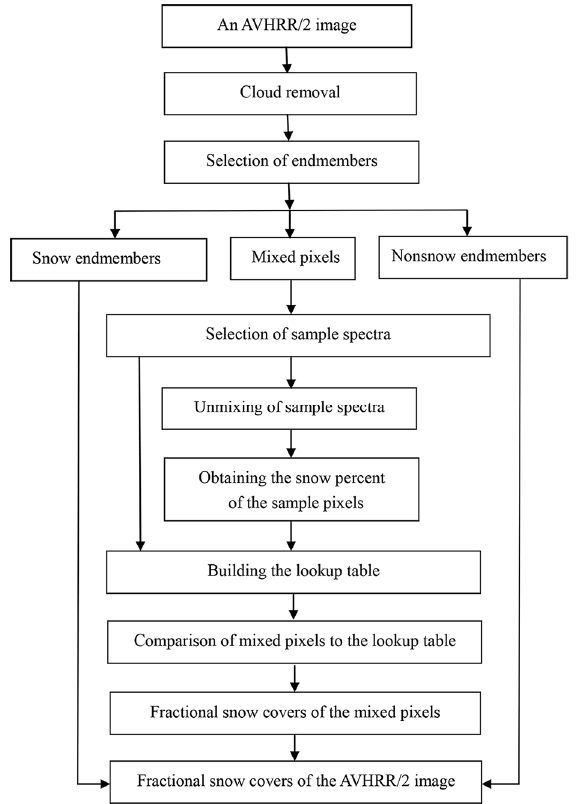
Figure 8. Steps of subpixel snow mapping using daily AVHRR/2 data.